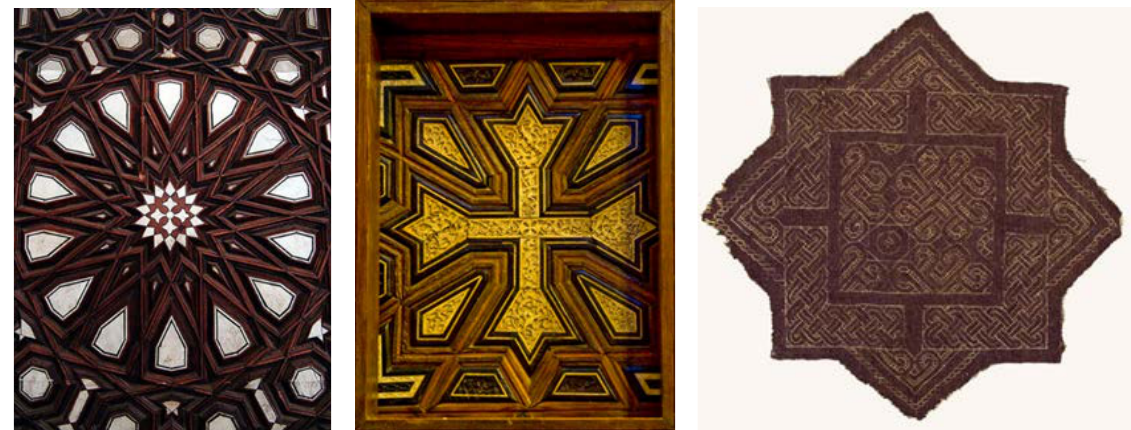
Figure 6-5 Woodworks, Hanging Church. Figure 6-6 Woodworks Hanging Church. Figure6-7 Coptic